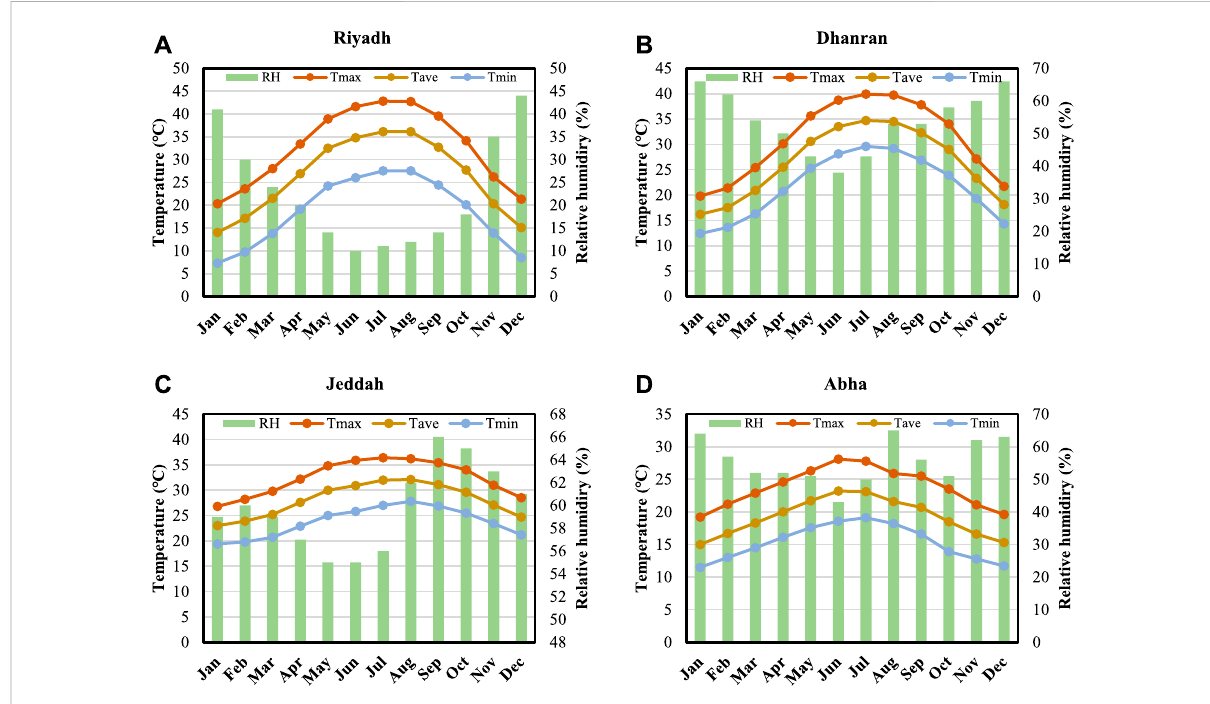
FIGURE 3 Annual weather data for representative cities of four regions: (A) Central region-Riyadh, (B) Eastern region-Dhanran, (C) , Western region- Jeddah and (D) Southern region-Abha (Wunderground,